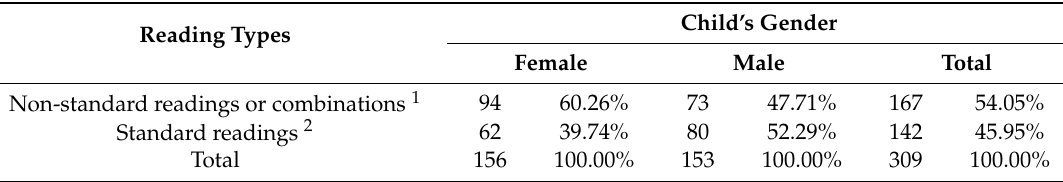
Table 3. Orthographic characteristics of children’s